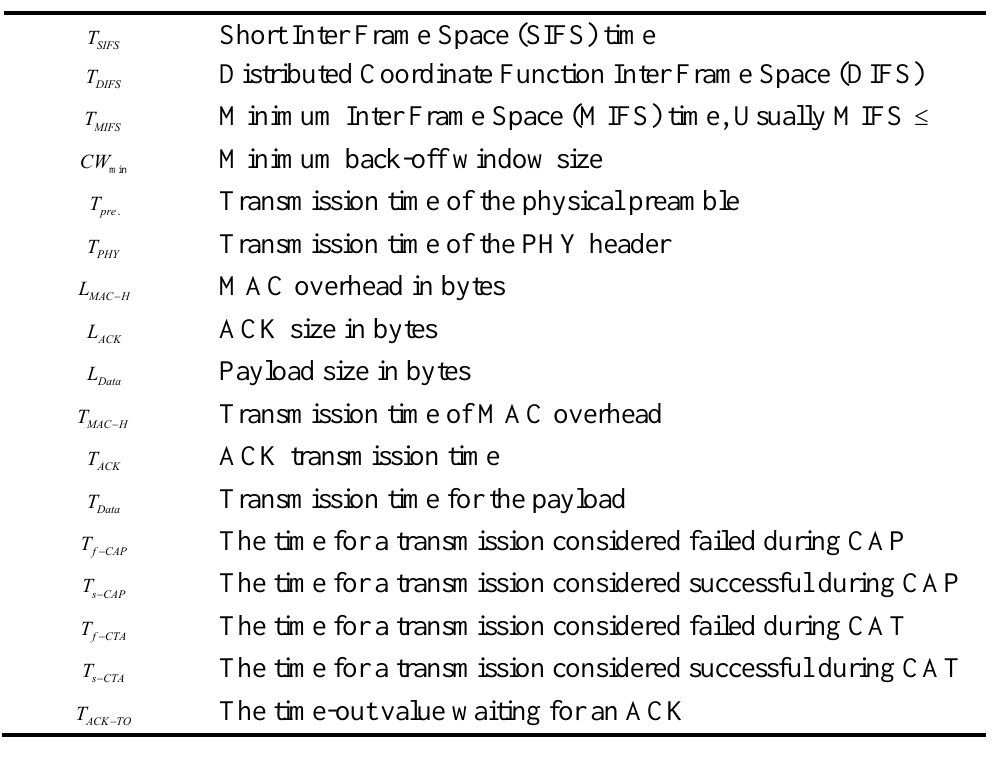
Table 1. Parameter